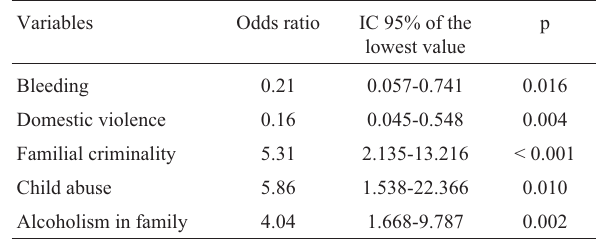
Table 2 - Multiple logistic regression of maternal characteristics and fa- milial history related to alcohol consumption.